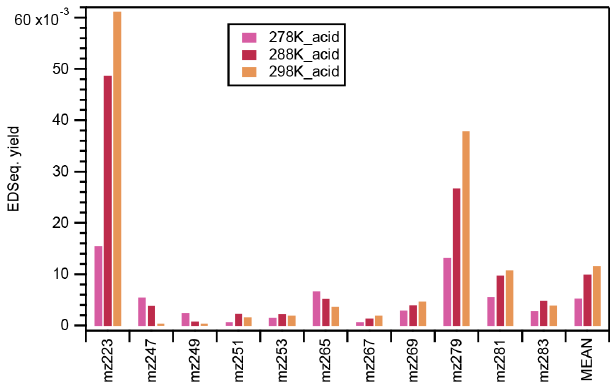
Figure 8. The ethyl-d5-sulfate equivalent (EDSeq.) yield of the 11 OS compounds and their arithmetic mean under acidic seed con- ditions at different temperatures. The retention time range used for the calculation of the intensity of each OS compound is indicated in Fig.